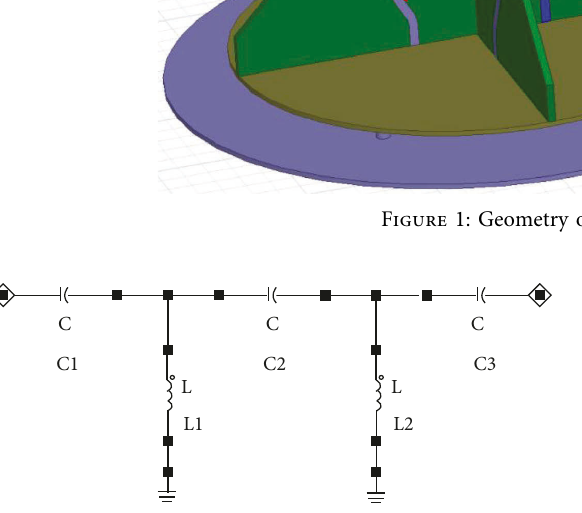
Figure 2: Equivalent circuit of CRLH-TLS structure.